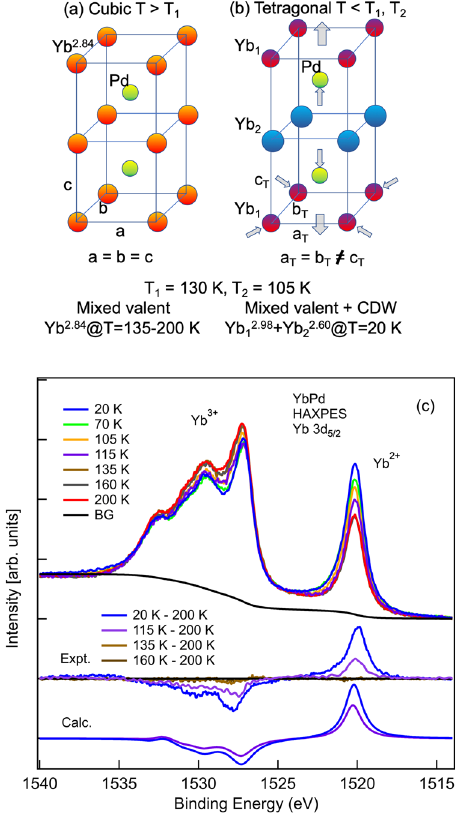
Fig. 1 Schematic structure of YbPd across the CDW transition and evolution of Yb mixed valence. Panels a and b show the schematic crystal structure in the cubic and tetragonal phases of YbPd. The cubic phase has a single crystallographic site, while the tetragonal phase has two distinct crystallographic sites, Yb 1 and Yb 2 , respectively. Panel c shows the experimental Yb-3d 5/2 core-level HAXPES of YbPd between 20 K and 200 K. The solid black line is the Shirley background subtracted to estimate the Yb-3d 5/2 -spectral weight. Below the CDW transition ( T 1 = 130 K), the spectra exhibit a T -dependent valence change but are T -independent above T T = 20 K and 1 . The experimental and calculated difference spectra for the T = 115 K obtained by subtracting the T = 200 K spectrum shows consistent change in mixed valence as discussed in the text, while the difference spectra for T = 135 K and T = 160 K show negligible